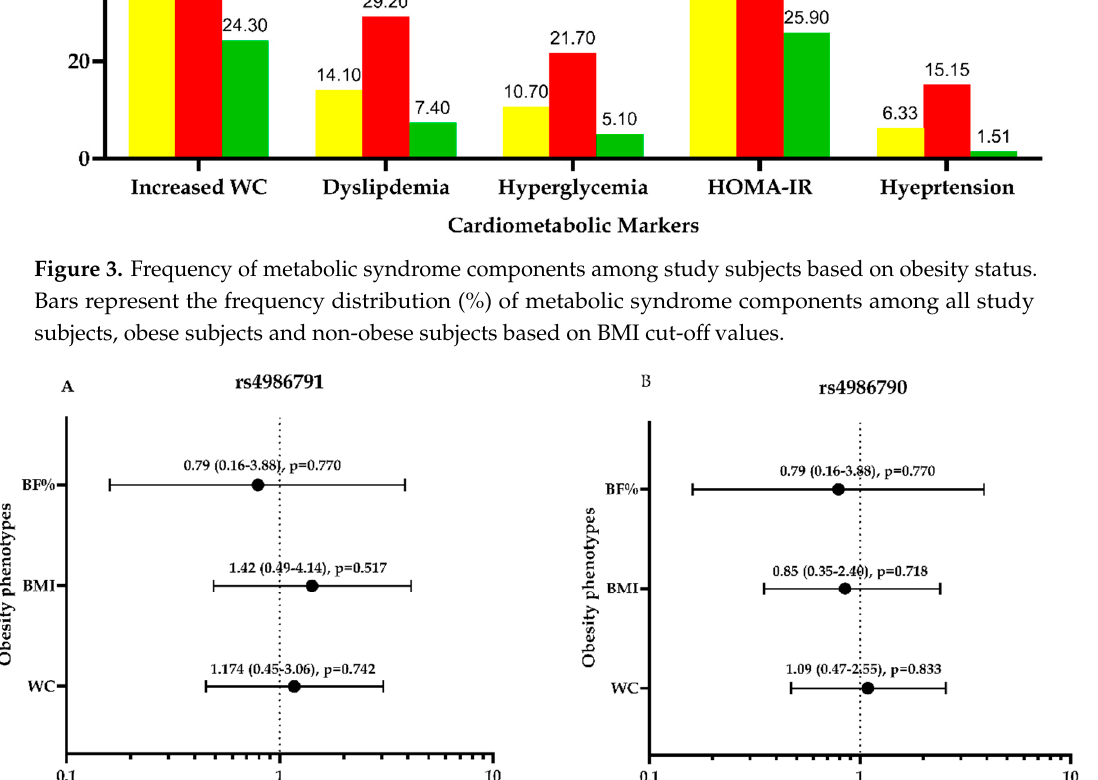
Figure 3. Frequency of metabolic syndrome components among study subjects based on obesity status. Bars represent the frequency distribution (%) of metabolic syndrome components among all study subjects, obese subjects and non ‐ obese subjects based on BMI cut ‐ off values.